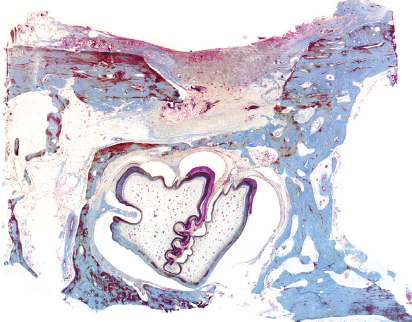
Figure 9: Histotopogram of a cross section of the mandible of the rabbit 4 weeks after the formation of a bone defect and introduction of calcium hydroxide suspension.